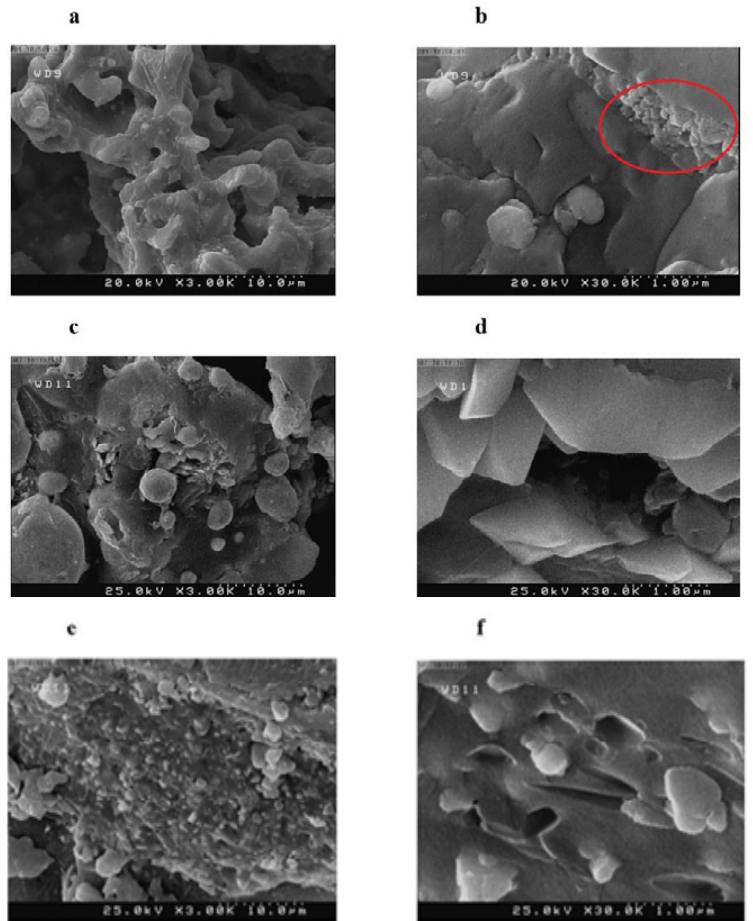
Fig. 3: SEM images of a,b) unknown spongy nanostructure fabricated from calcination of compound 1 at 450 °C, c,d) packed nanosheets of silver and silver sulfate mixture prepared from calcination of compound 1 at 500 °C, and e,f) mixture of silver and silver sulfate microstructure prepared from calcination of compound 1 at 700